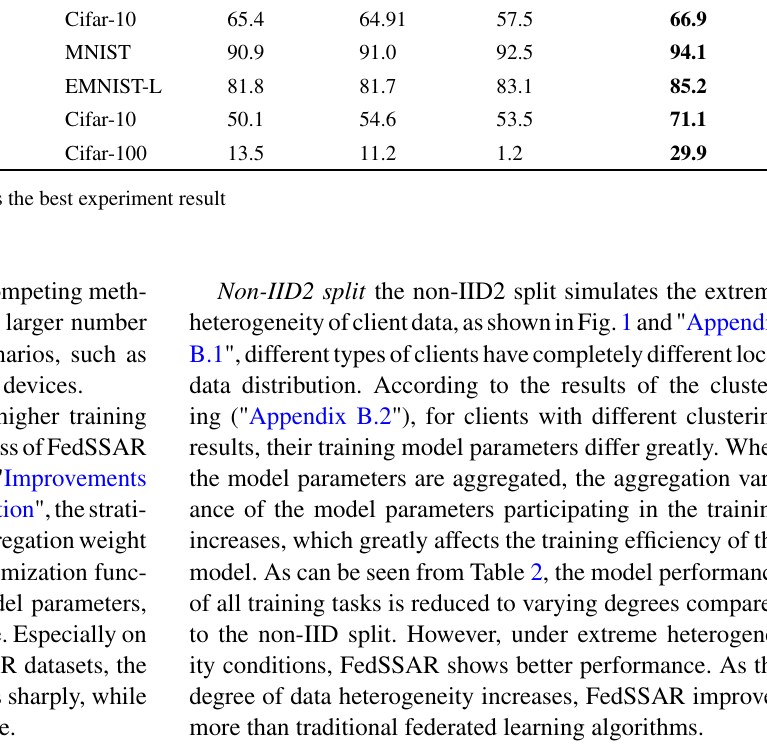
Table 1 Average validation performance over the last 50 rounds for MNIST and EMNIST-L, 500 rounds for Cifar-10 and Cifar-100; % accuracy; on non-IID split